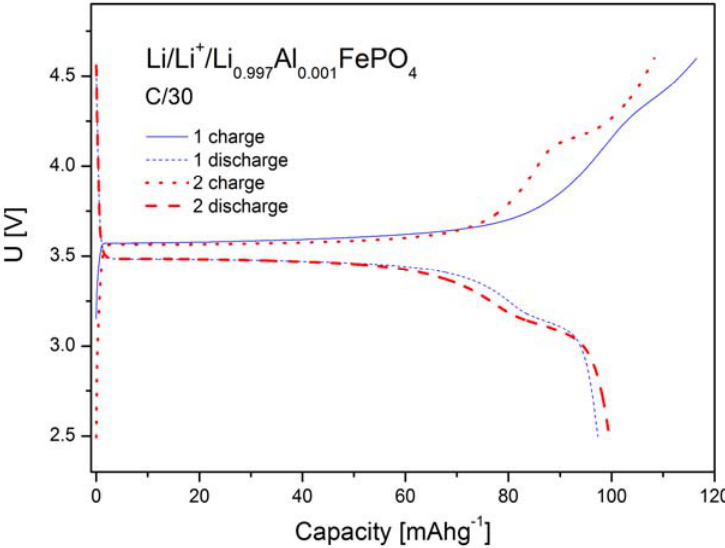
Al FePO 0.997 0.001 4